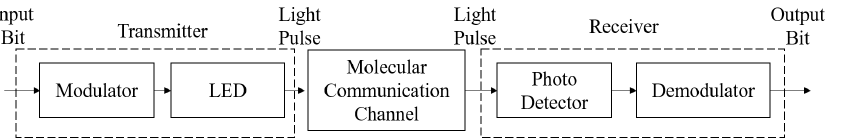
Figure 1. Block diagram of diffusive molecular communication.